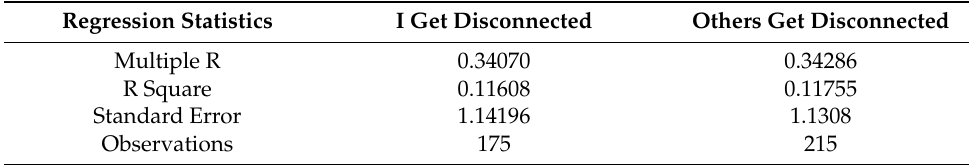
Table 6. The summary output for the disconnection group of